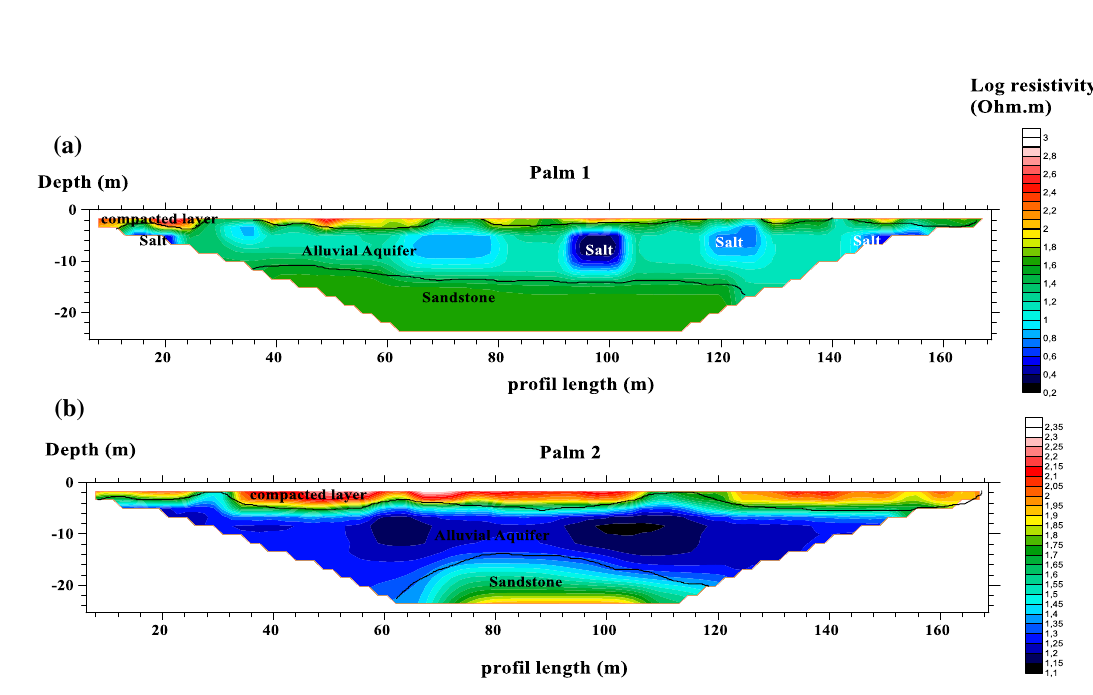
Fig. 6 2D Electric tomography for profiles palm 1 and palm